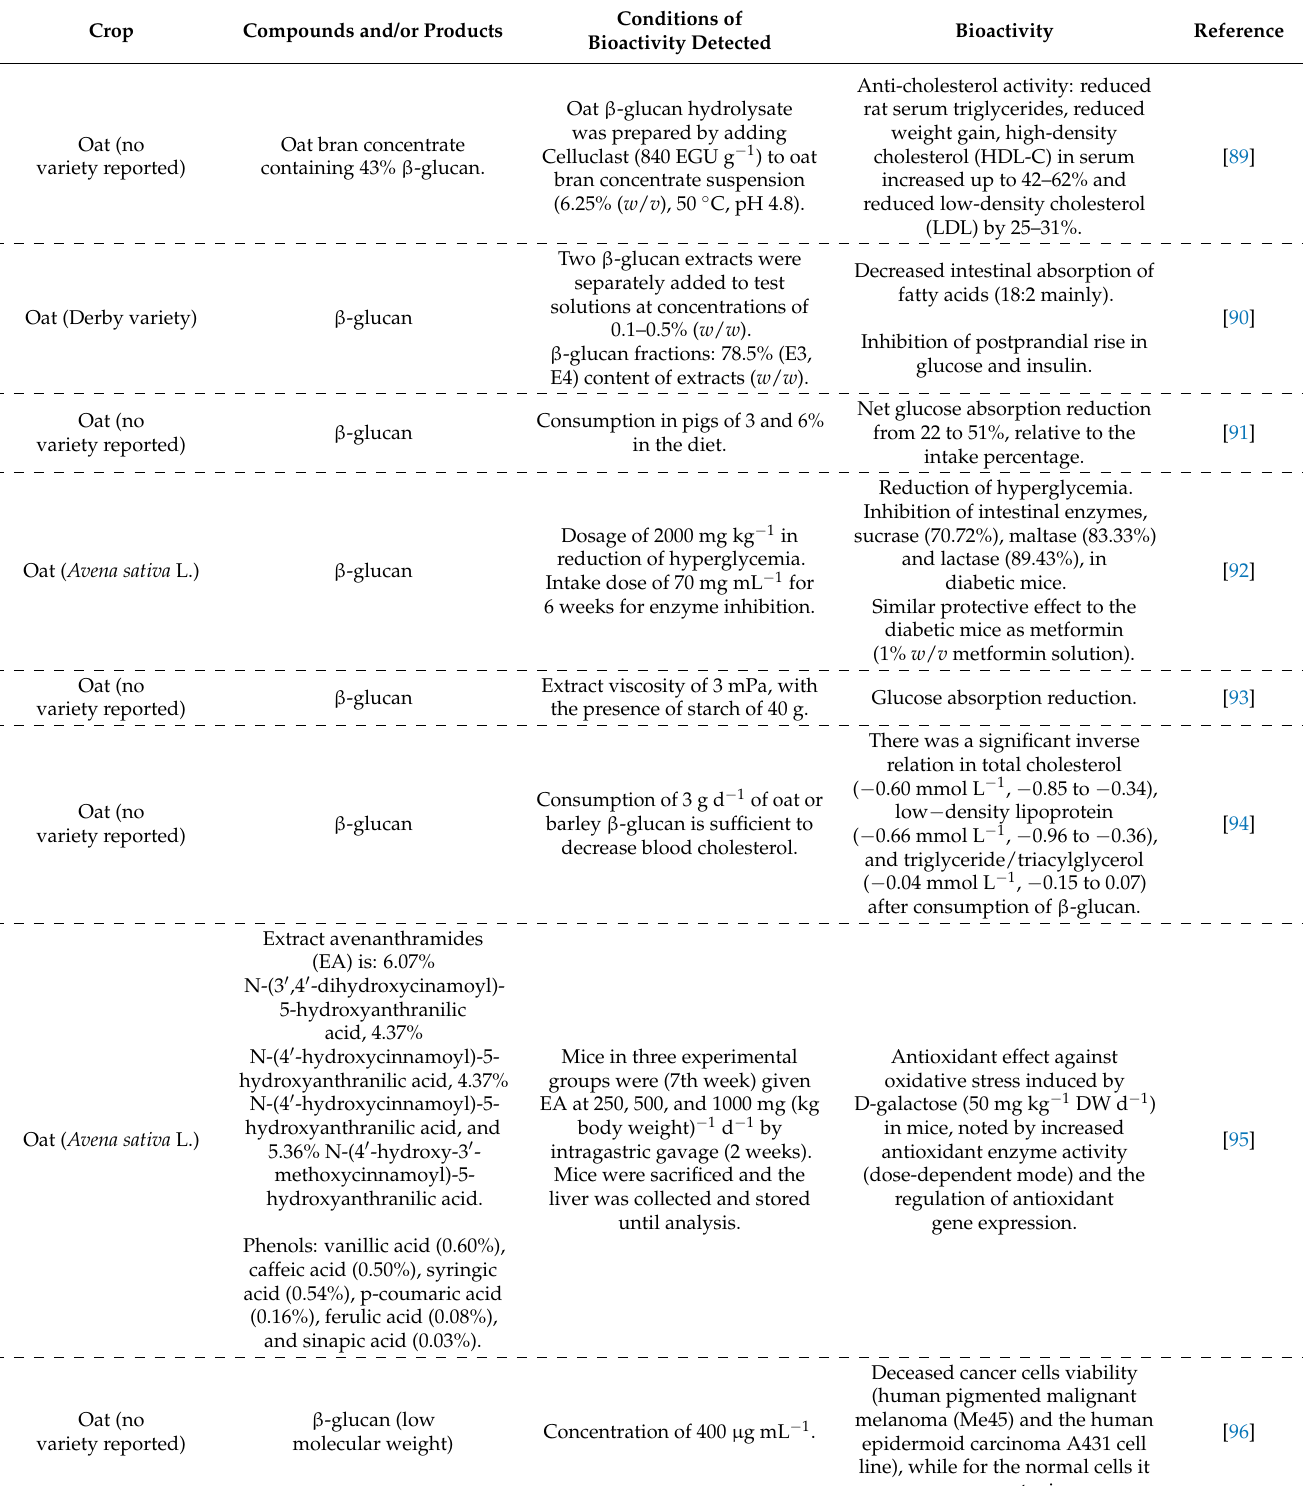
Table 5. Composition and/or bioactivity determined in oat ( Avena sativa